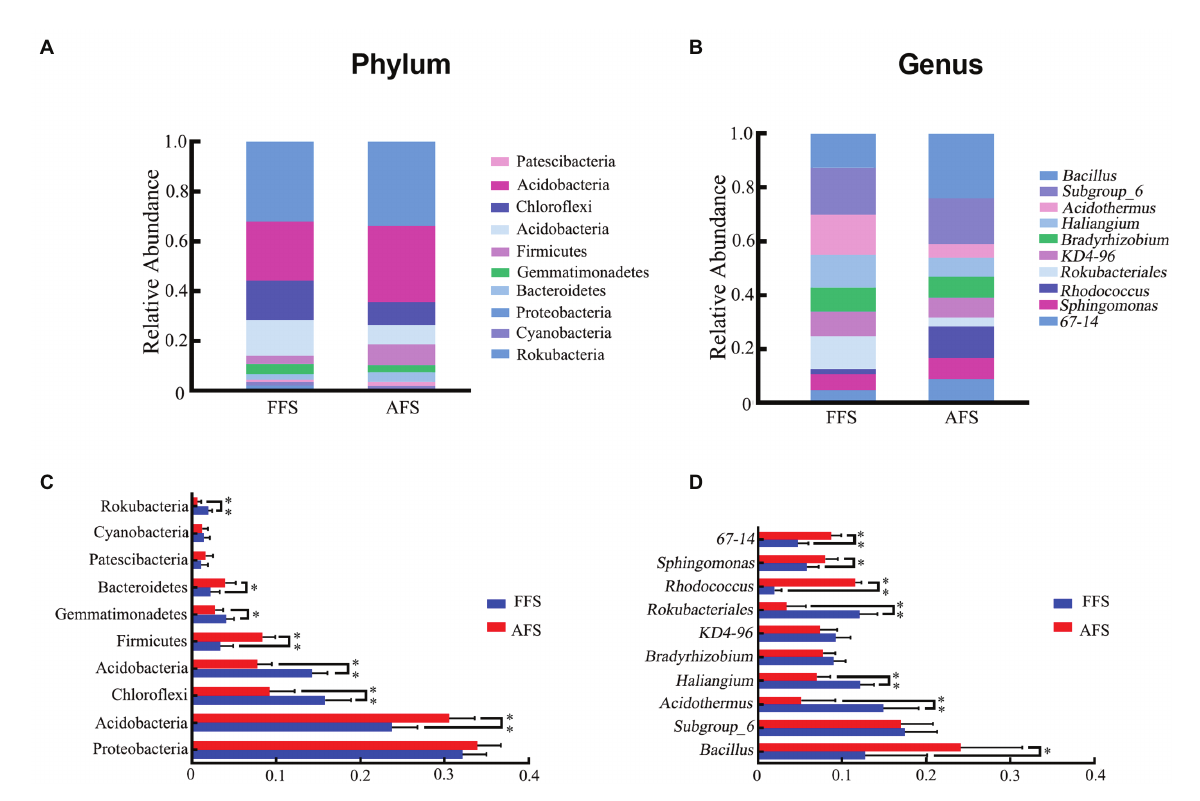
FIGURE 4 Relative abundance of 10 dominant bacterial phyla (A, C) and 10 dominant genera (B, D) (relative abundance >1% in at least one sample) in the soil bacteria for the FFS and the AFS (mean ± SD, Kruskal–Wallis test, * p < 0.05, ** p < 0.01). Different colored shapes represent different phyla or